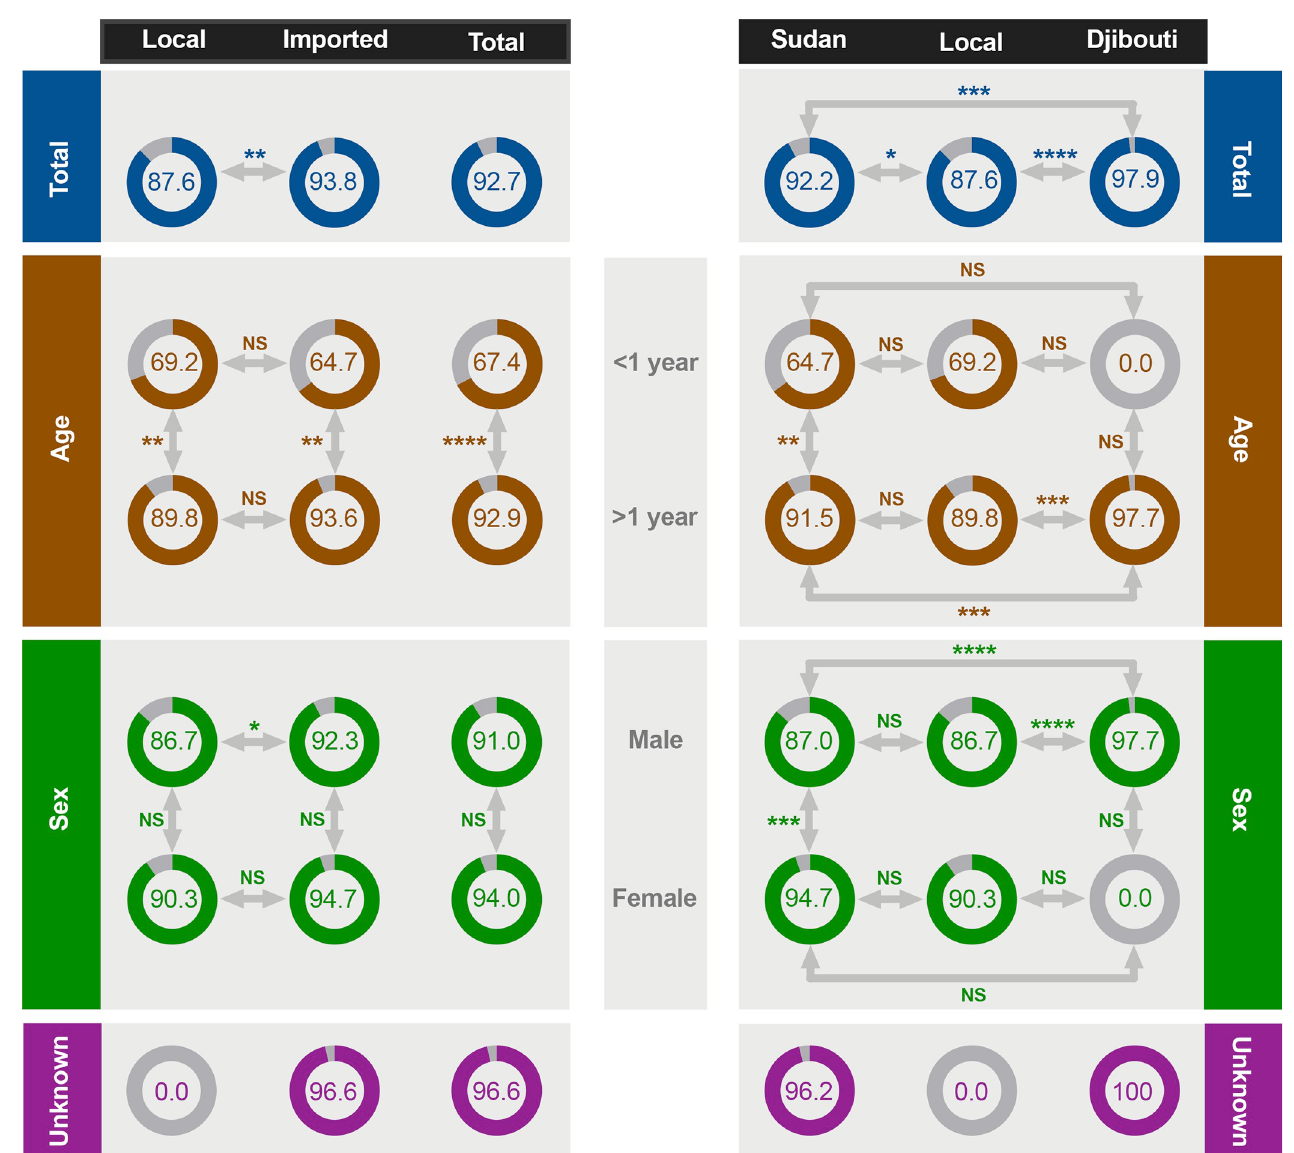
Fig 2. Seroprevalence rate in imported and local dromedary camels based on age and sex. Percentage of seroprevalence is shown for each category. ���� p < 0.0001, ��� p < 0.001, �� p < 0.01, � p < 0.05 and NS denotes not statistically significant (Fisher Exact Test).